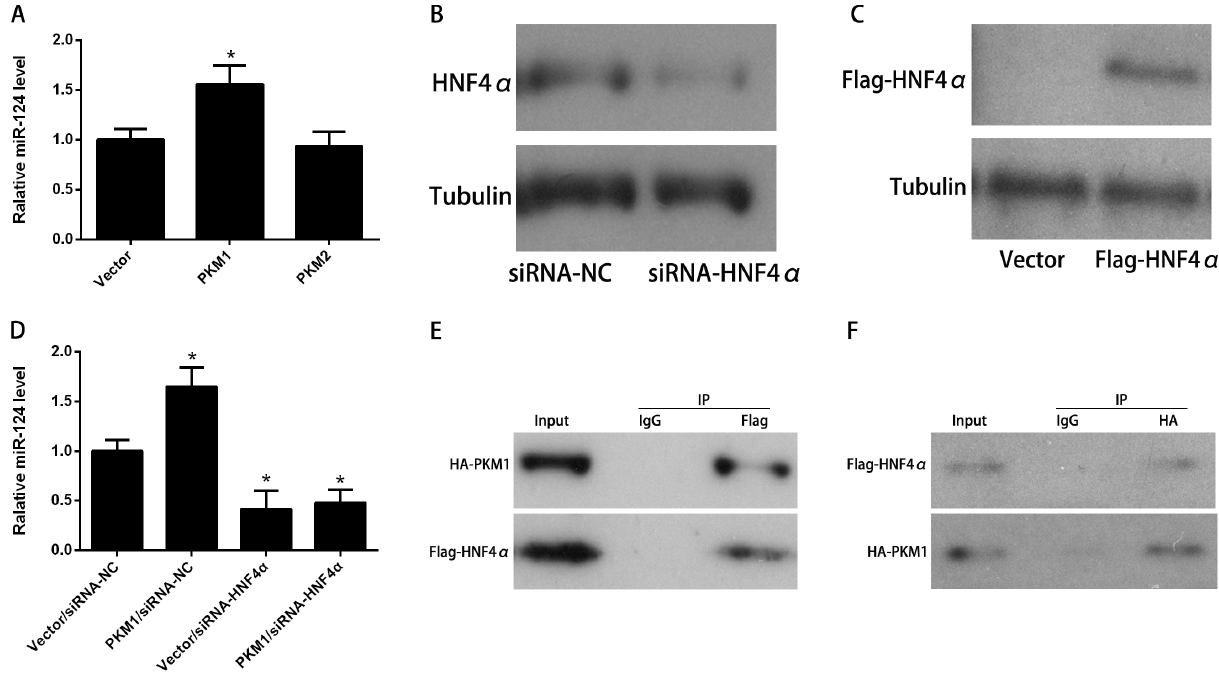
Figure 3. PKM1 regulates miR-124 expression via HNF4 α . ( A ) To test whether